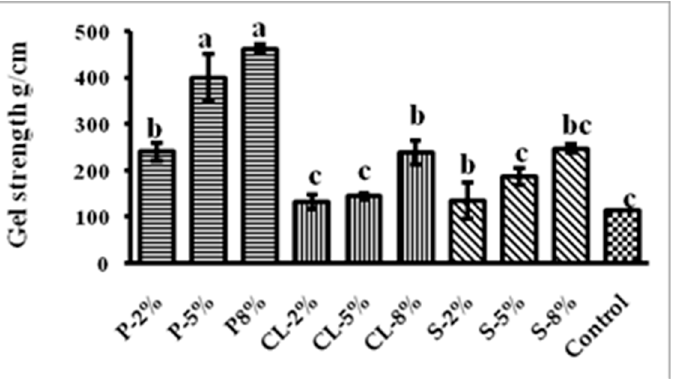
Figure 1. Gel strength of different gel-based feeds. Data are represented as mean ± SE. Different superscripts indicate significant differences ( p <0.05) among the experimental groups.